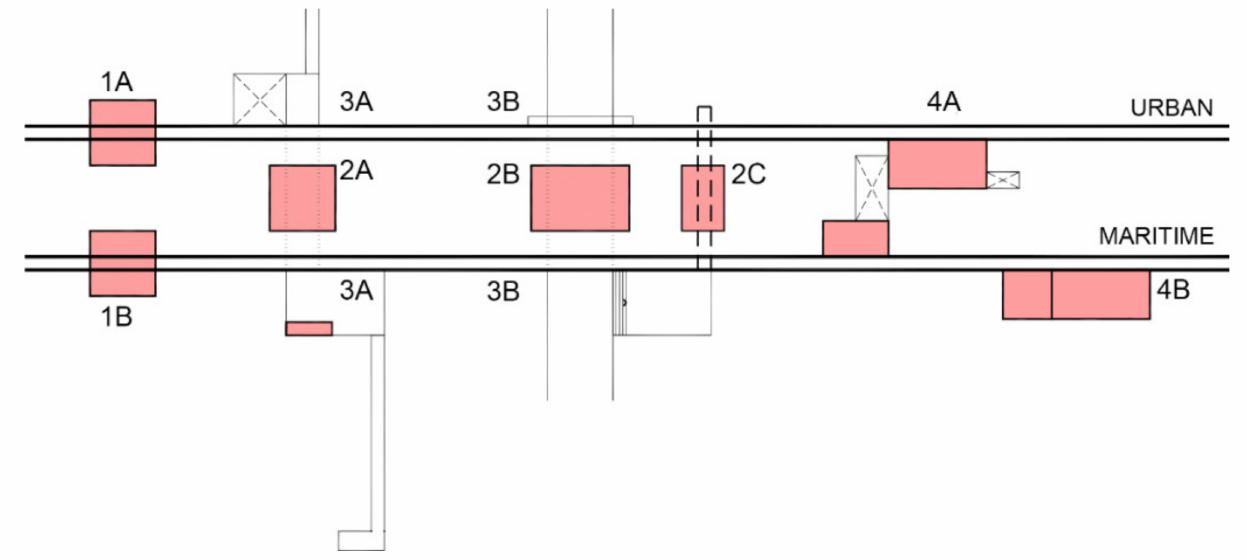
Figure 13. Matrix of standardized design solutions (Source: authors’ own). 1A_ Longitudinal/Urban represents the typological solution for the urban civic